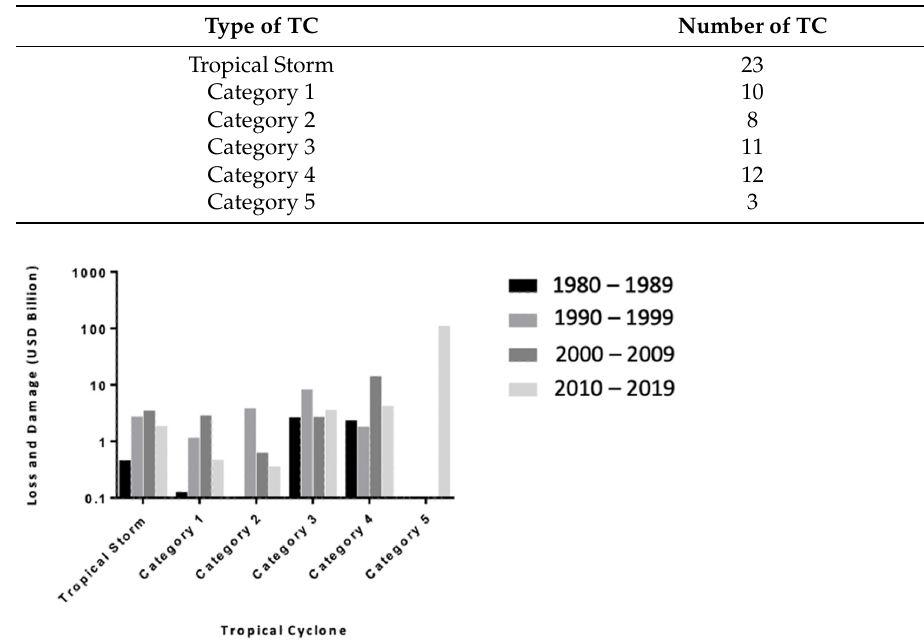
Table 1. Types and number of TC occurred in the region between 1980–2019.